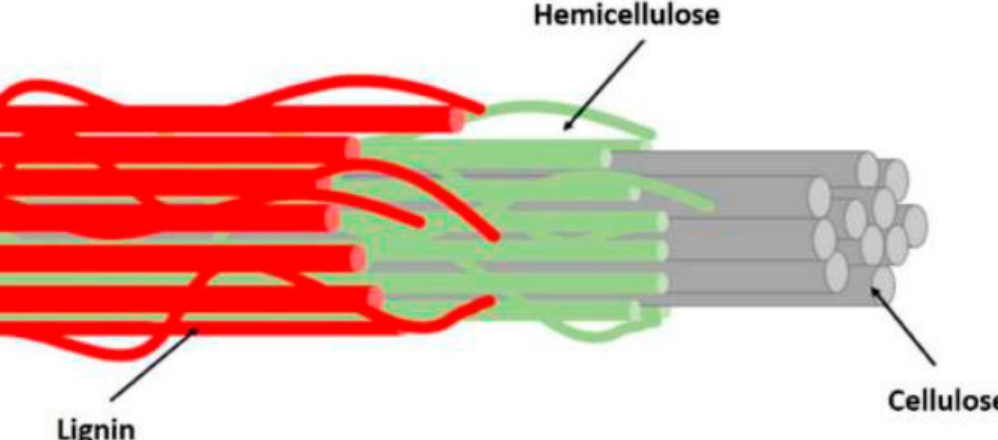
Figure 5. Schematic diagram of components of lignocellulosic fibre. Adapted with permission from Ref. [95]. Copyright 2021 MDPI.